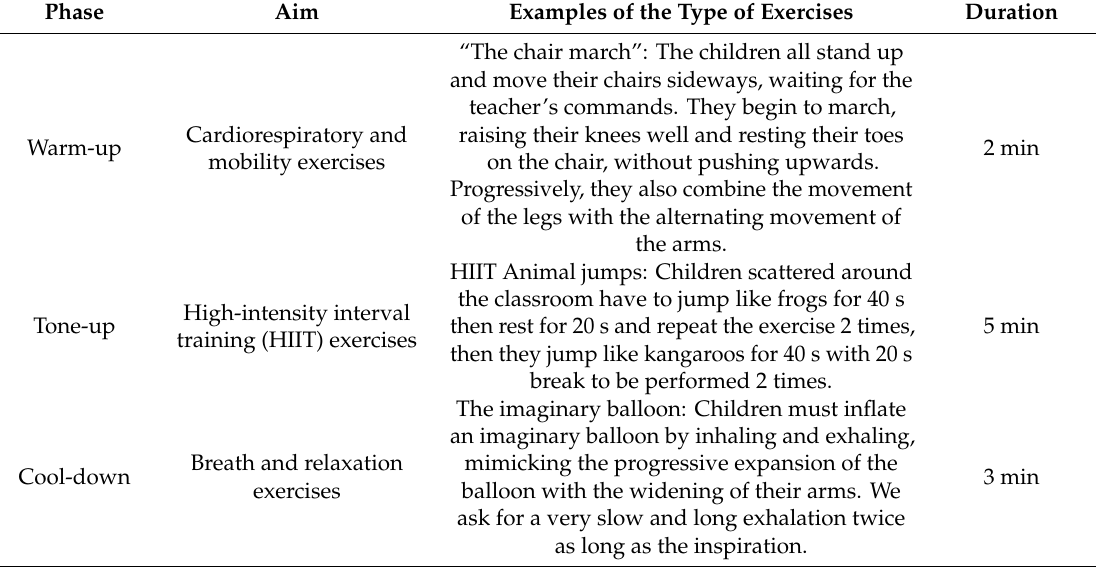
Table 1. Components of I-MOVE